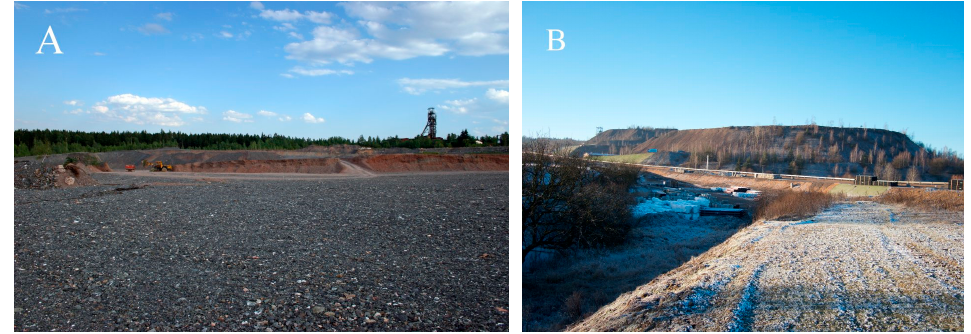
Figure 2. Dump of the shaft ( A ) 16-Háje in 2007 and ( B ) 11A-Bytíz in 2017. Photos by P.